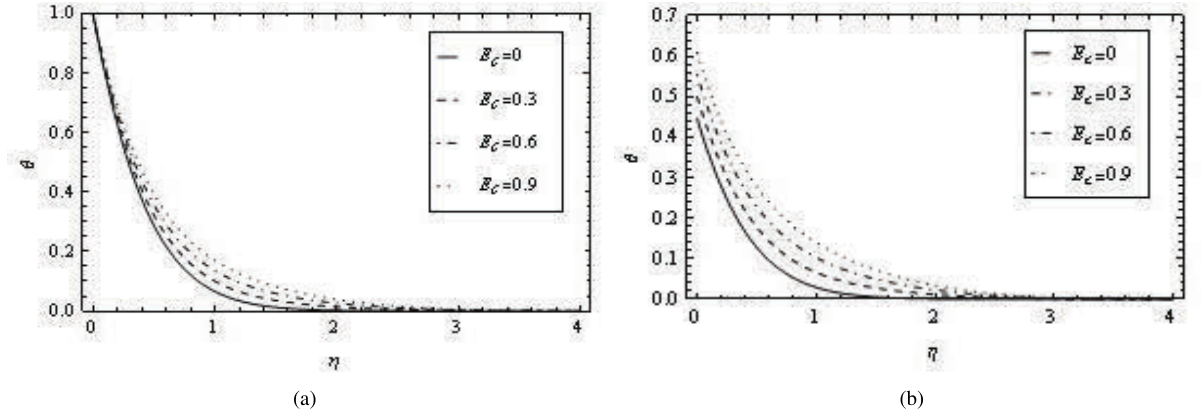
Figure 4. The effect of Eckert number E c on temperature when n D 1:25; ˇ D 0:6; (cid:21) 1 D (cid:21) 2 D 0:5; P r D 3 and k D 1:5 (a) for PST and (b) PHF cases.